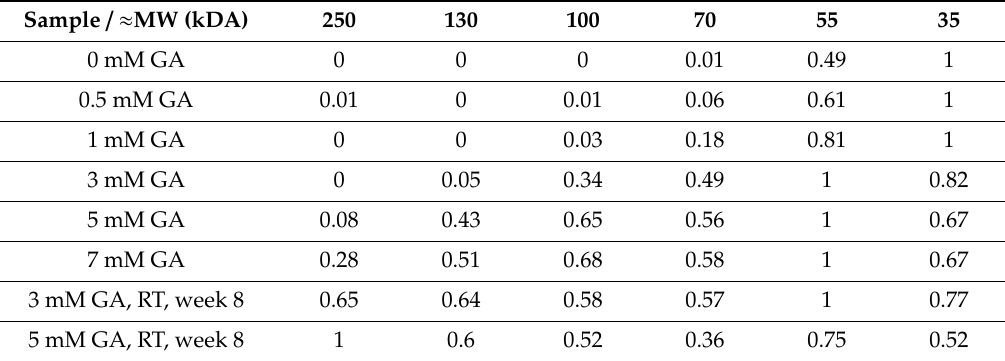
Table 3. Profile of relative intensities of protein bands.